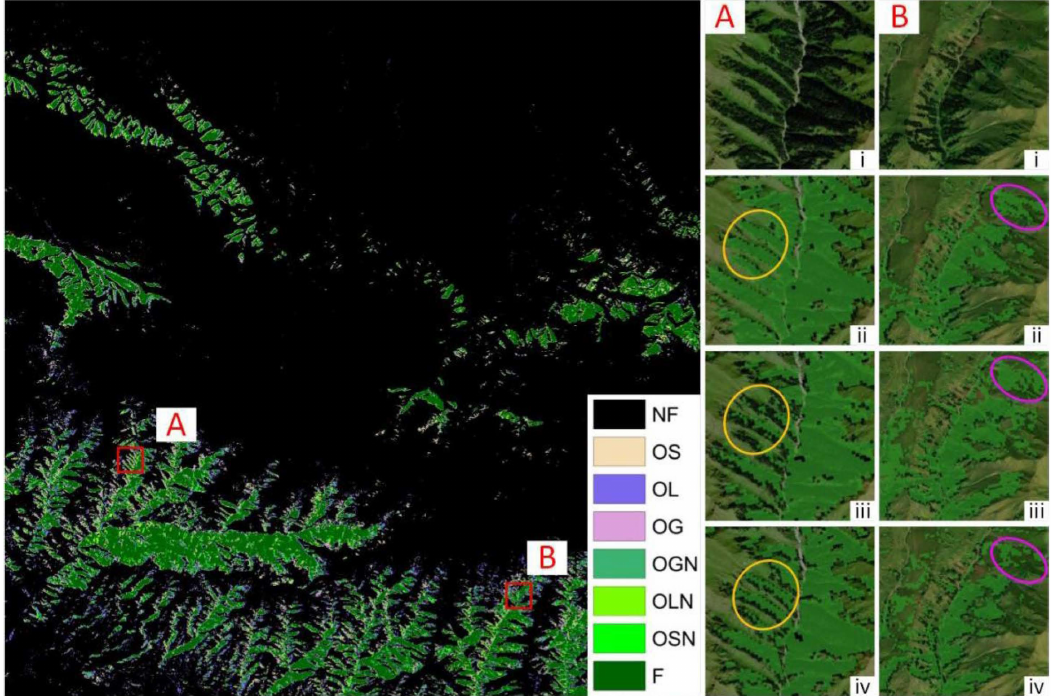
Figure 10. Classification results of images from different sensors in area